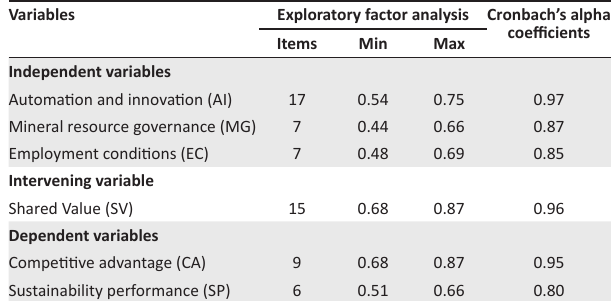
TABLE 2: Summary of validity and reliability